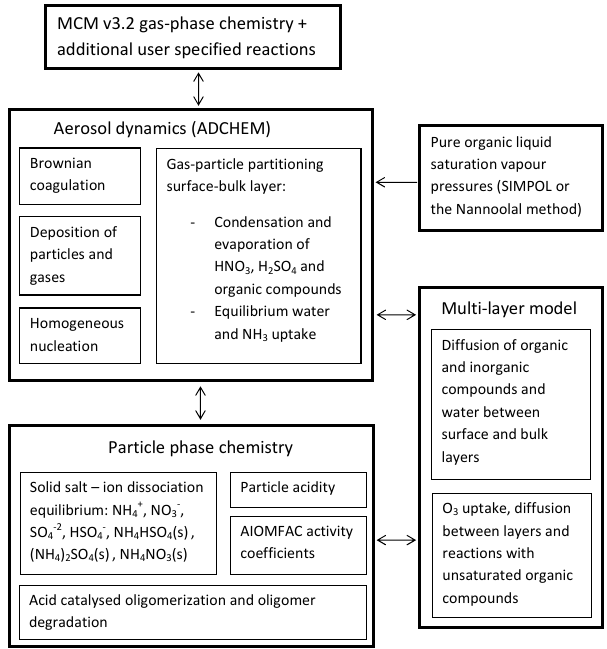
1 Figure 1. Schematic picture of the ADCHAM model structure. 2 Figure 1. Schematic picture of the ADCHAM model